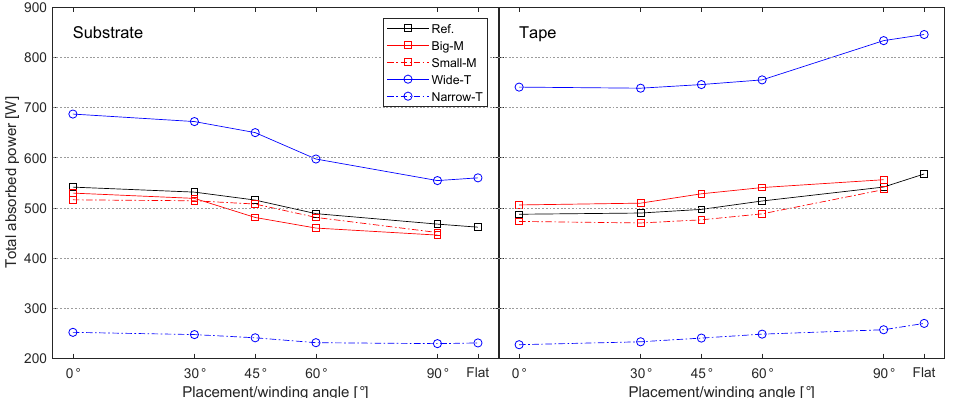
Figure 12. The total absorbed power for the substrate and tape calculated based on the incoming and reflected energies for each case study listed in Table 3.